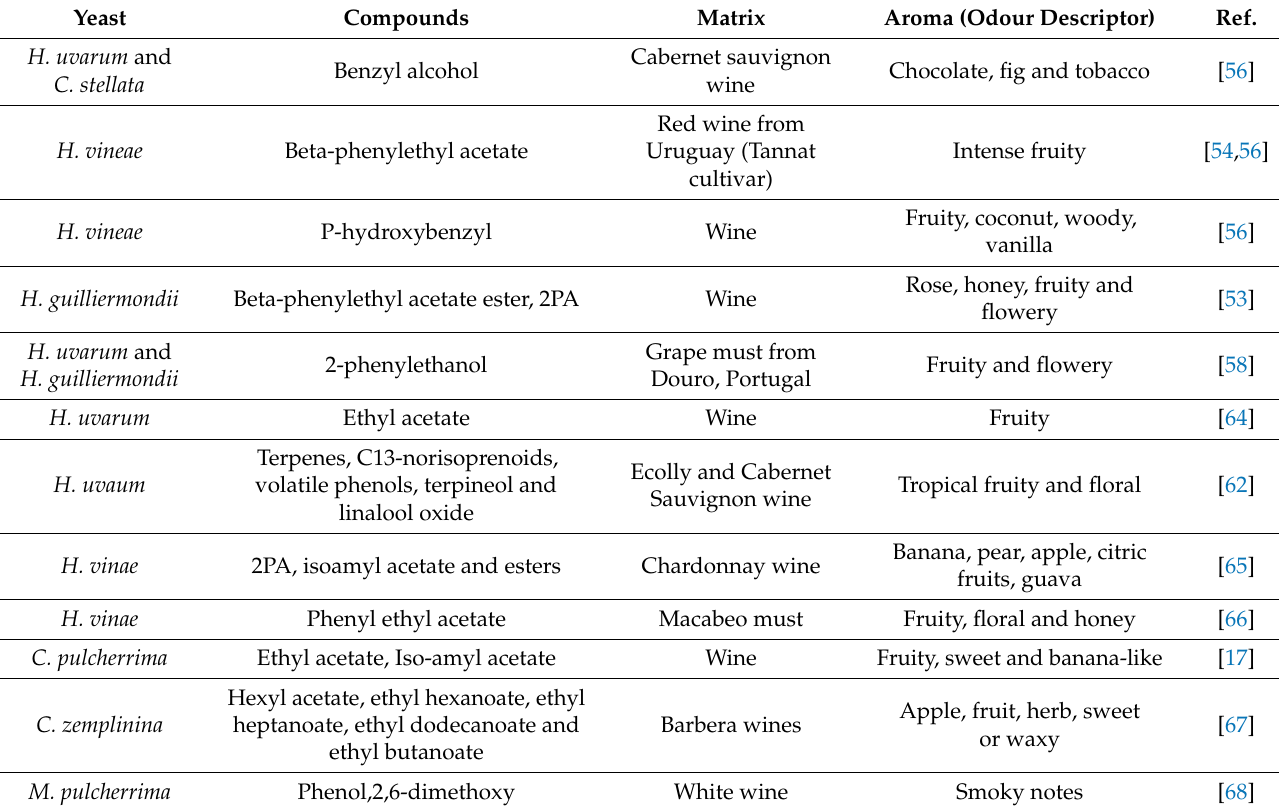
Table 2. Different aroma compounds produced by yeast which confers good characteristics and pleasant aromatic properties to wine.